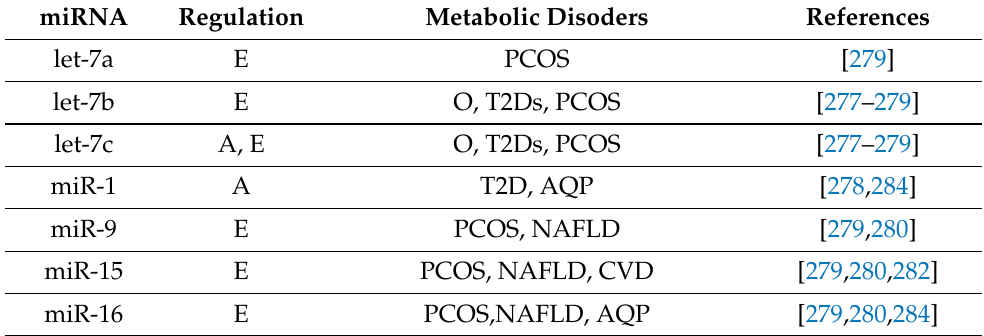
Table 2. Gonadal steroid-regulated microRNAs involved in metabolic diseases and AQPs functioning. miRNA